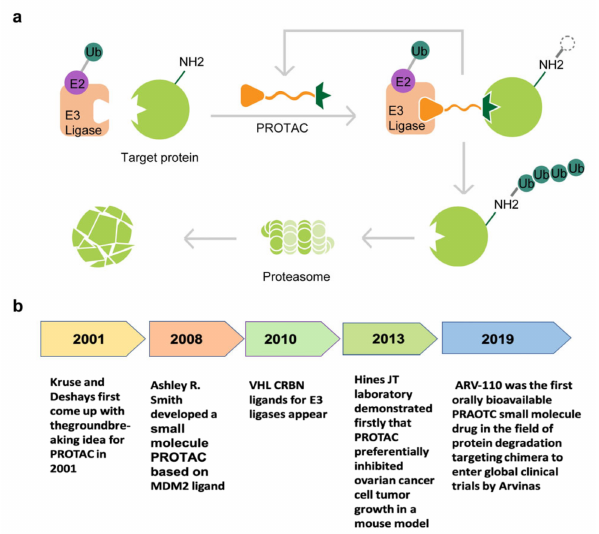
Figure 1. The structure and development process of protac: ( a ) The structure of PROTAC and the mechanism by which it targets protein degradation [8]; ( b ) Major events in the history of PRO- TAC